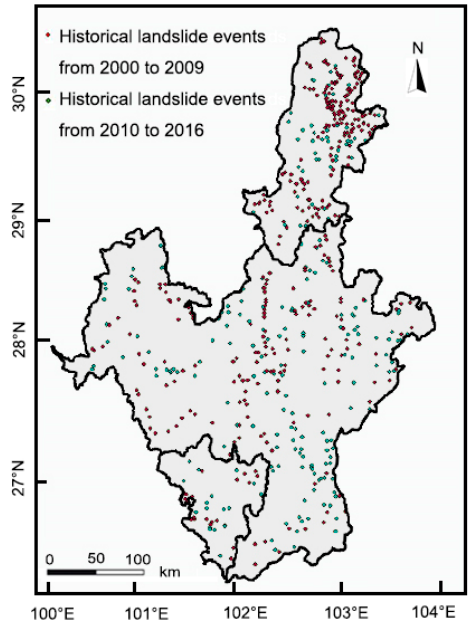
Figure 3. Locations of historical landslide events.